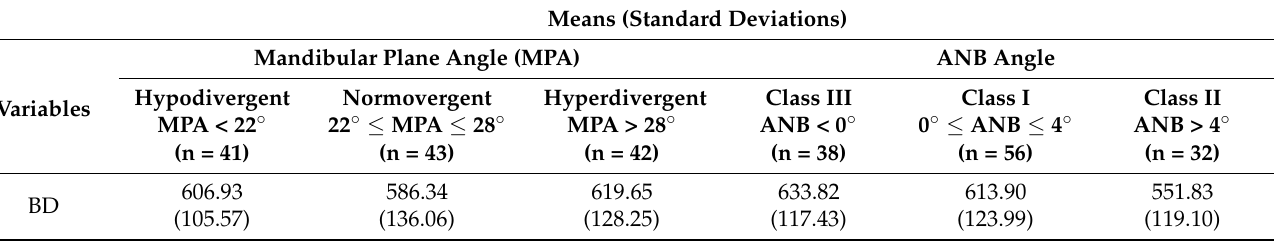
Table 3. Midpalatal bone density (BD) according to skeletal patterns (HU).